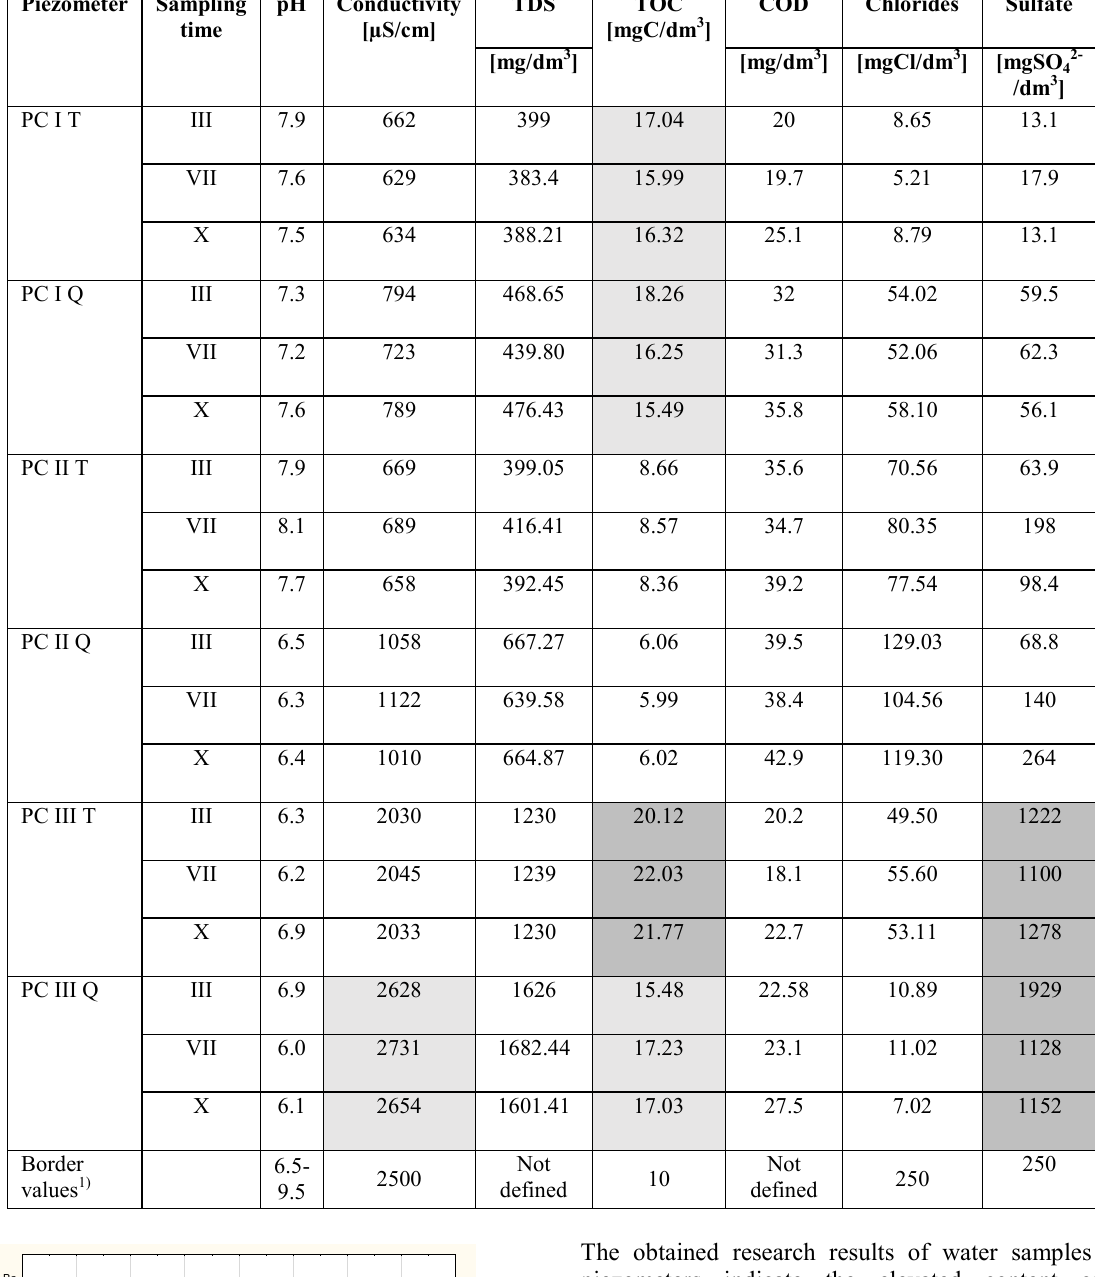
Table 3. Characteristics of water collected from piezometers.